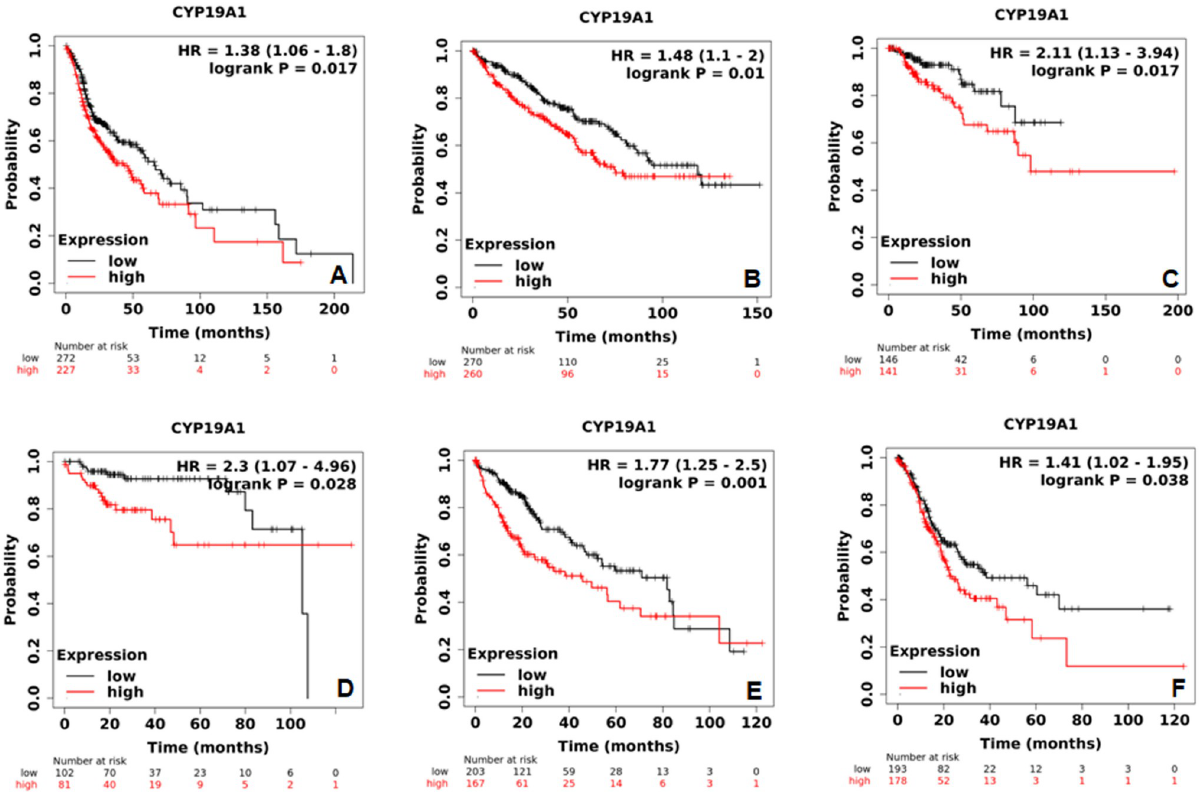
Fig 1. Effect of aromatase mRNA expression on OS in head-neck squamous cell carcinoma (A), kidney renal clear cell carcinoma (B) and kidney renal papillary cell carcinoma (C) patients. (D) Effect of aromatase mRNA expression on RFS in kidney renal papillary cell carcinoma. Effect of aromatase mRNA expression on OS in liver hepatocellular carcinoma (E) and stomach adenocarcinoma (F) patients.